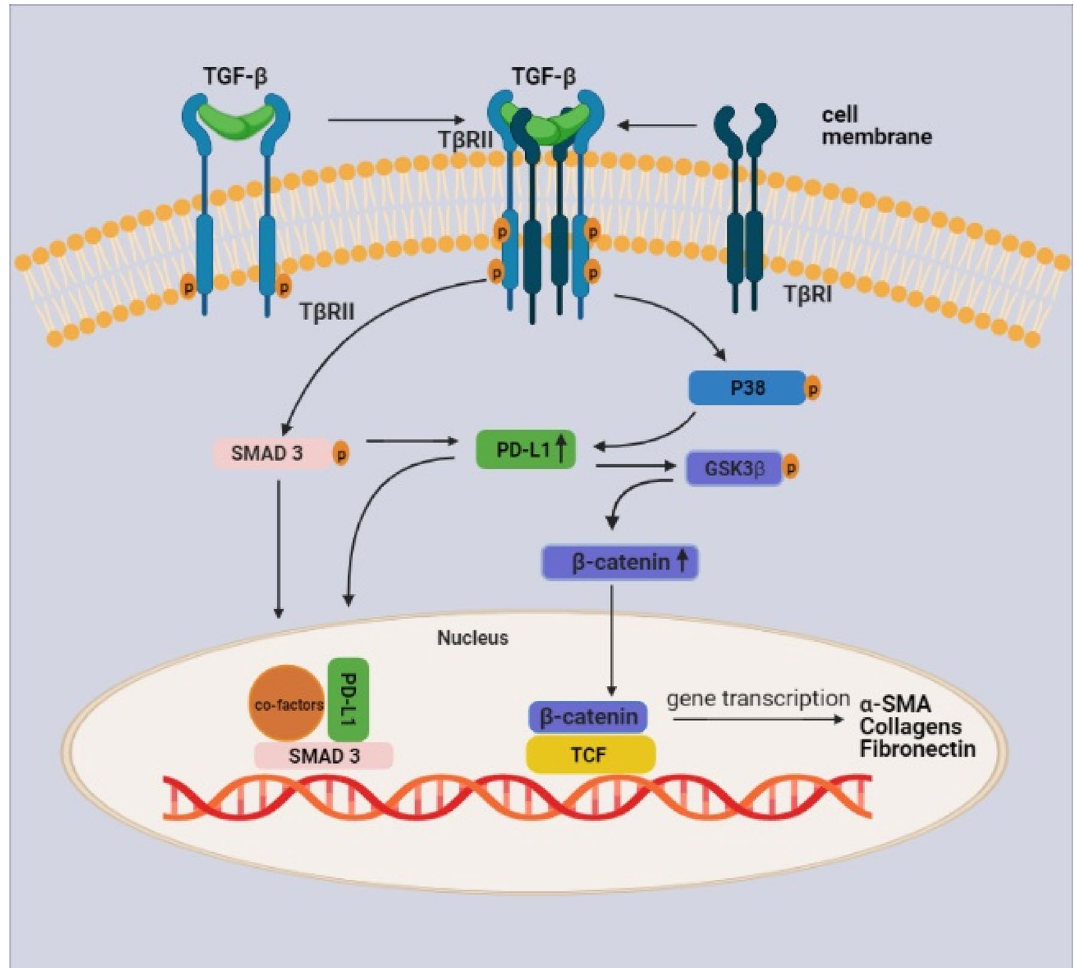
Figure 8. Schematic view of the proposed mechanisms by which PD-L1 mediates FMT induced by TGF-β in HLFs. The binding of active TGF-β with cell surface receptors (TGF receptor I and II, TβRI and TβRII) activates the receptor kinase which further recruits and phosphorylates Smad3. Activated Smad3 then translocate into the nucleus where it binds with other co-factors to activate transcription of FMT related genes. PD-L1 can be increased by Smad3 and p38 pathways downstream of TGF-β. Increased PD-L1 further binds to Smad3 and enhance its transcription activation of FMT genes including α-SMA. In addition, PD-L1 also facilitates GSK3β phosphorylation at Ser9 and thus inhibiting GSK3β dependent degradation of β-catenin. Increased β-catenin may also contribute to TGF-β induced FMT gene expression through binding with the transcription factor, T cell factor